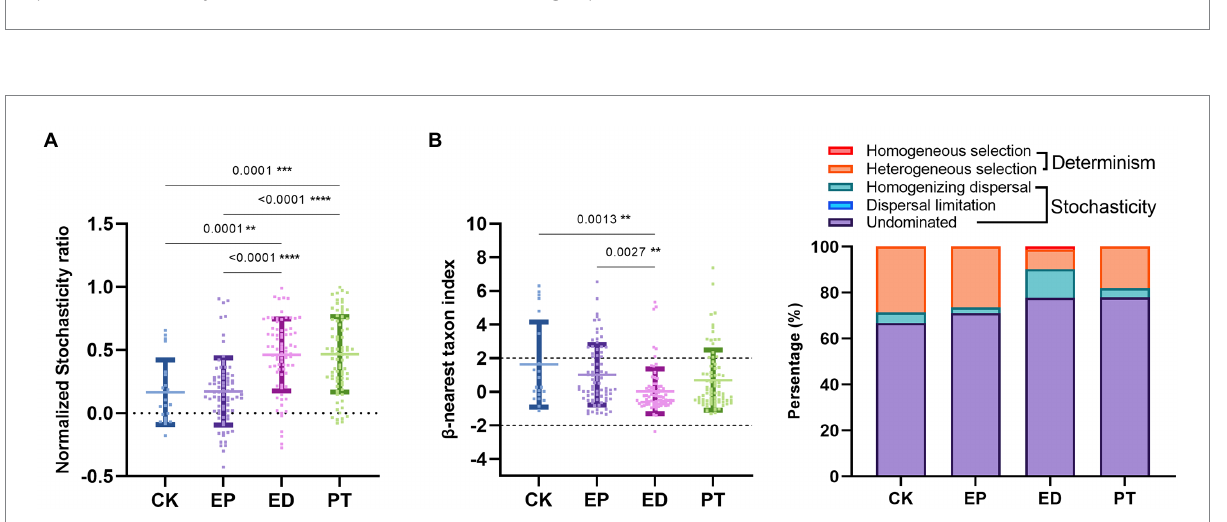
FIGURE 1 Comparison of gut microbiome structure at the amplicon sequence variant (ASV) level in epilepsy (EP), epilepsy with diarrhea (ED), additional probiotic treatments (PT), and healthy infants (CK). (A) Chao1 and Faith’ PD indexes in different groups. (B) The principal coordinate analysis (PCoA) plot based on the Bray–Curtis distance metric of ASVs in different groups.